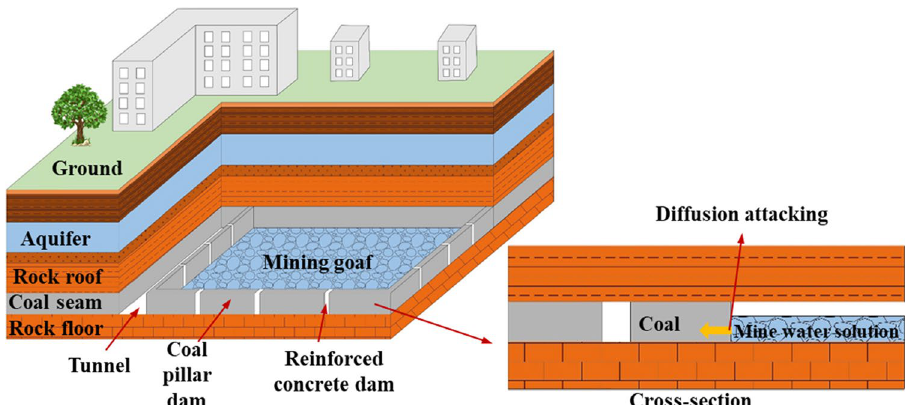
Fig. 1 Schematic diagram for underground water